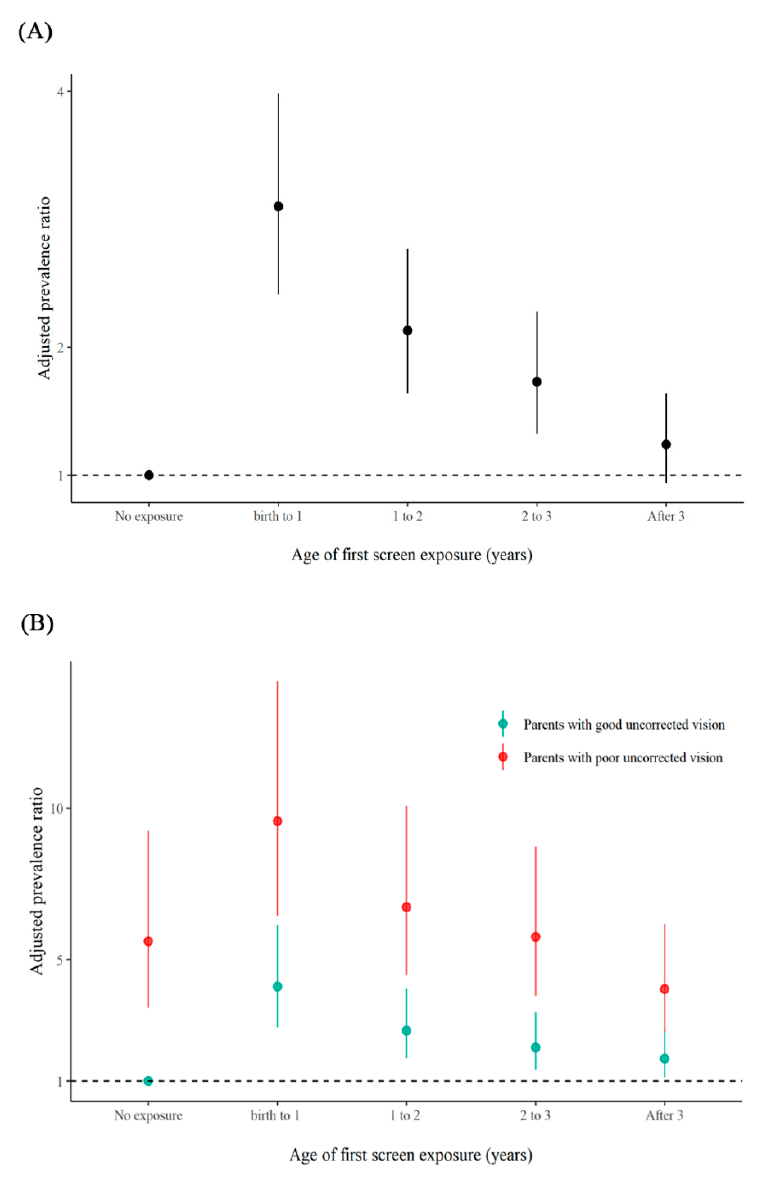
Figure 1. Associations between the initial age of screen exposure and preschool astigmatism. ( A ): Associations between the age of first screen exposure and preschool astigmatism. ( B ): Associations between the age of first screen exposure and preschool astigmatism stratified by the status of parental eyesight.